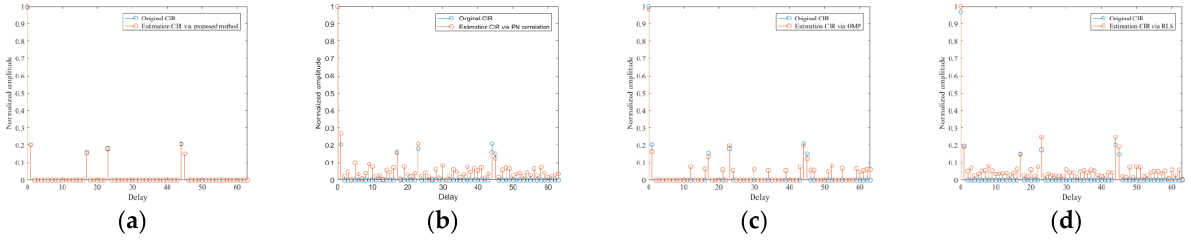
Figure 6. Autocorrelation results of reference signal in different channel model: ( a ) reference signal in Brazil A; ( b ) ref- erence signal in COST207; ( c ) ideal reference signal.